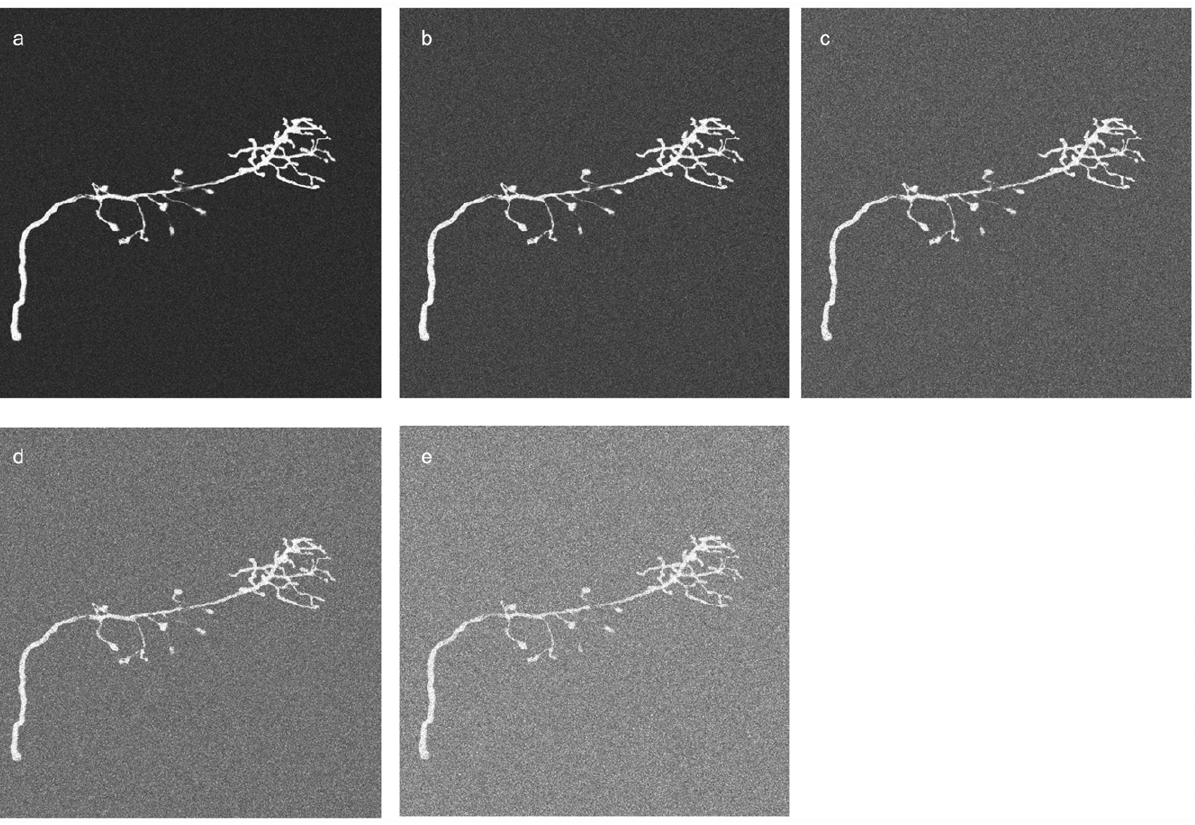
Figure 7. The histogram for all five different noise levels. We can find that the distributions of five noise levels are almost the same.